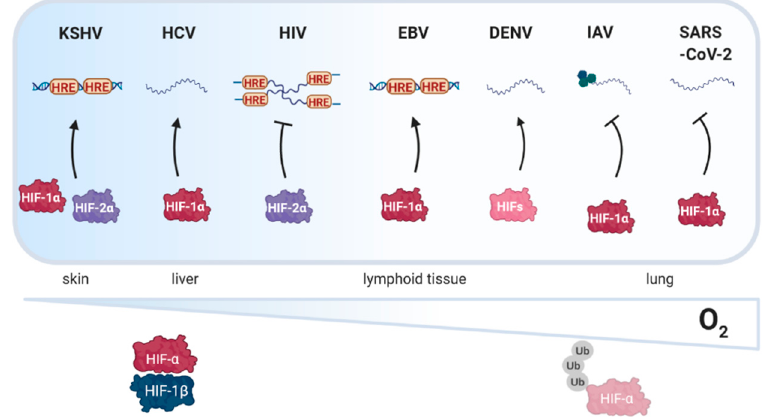
Figure 3. Schematic illustration depicting how oxygen tension in different tissues affects viral replication. Hypoxia inducible factor (HIF) signaling enhances (black arrow) the replication of Kaposi’s sarcoma associated herpesvirus (KSHV), hepatitis C virus (HCV), Epstein Barr virus (EBV) and dengue virus (DENV). In contrast, human immunodeficiency virus type I (HIV-1), influenza A virus (IAV) and severe acute respiratory syndrome coronavirus 2 (SARS-CoV-2) replication is dampened by HIF signaling. HRE, HIF response element, Ub, ubiquitin. Created with BioRender.com.